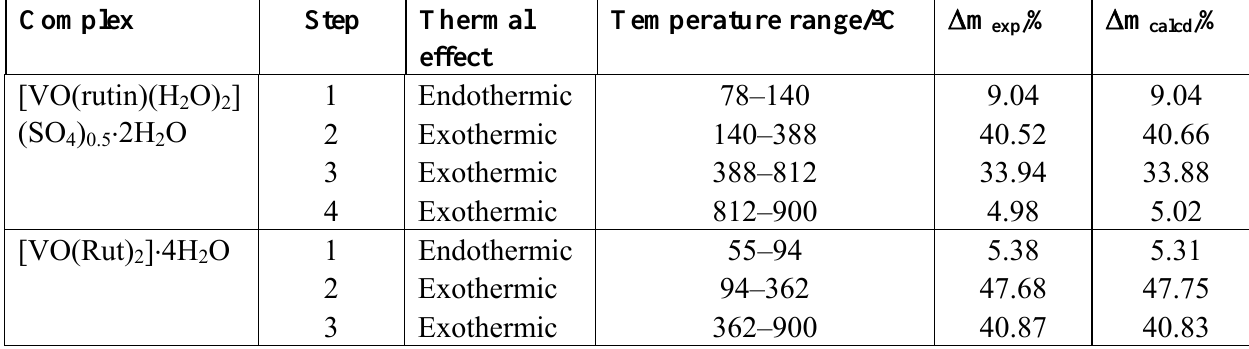
Table 3. Thermal behavior data (in synthetic air) for